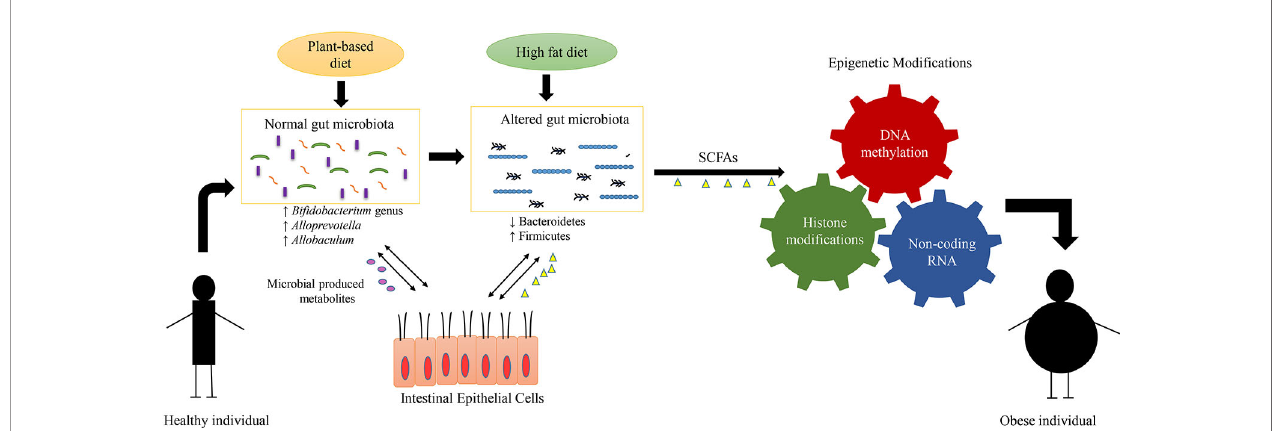
FIGURE 2 | Interplay between diet, gut microbiome, epigenetic mechanisms, and obesity. The alterations in composition of microbial communities mainly arise due to difference in dietary patterns. The plant-based diets have been known to be associated with diverse and particular gut fl ora such as Bi fi dobacterium genus, Alloprevotella, and Allobaculum . The diverse composition of gut microbiota results in production of various metabolites such as short-chain fatty acids (SCFA). These gut microbial-produced metabolites interact with the epithelial cells of the host and help to maintain the host metabolism. On the other hand, the diets enriched in fat and carbohydrate, result in lowered gut diversity and alterations in the composition of gut microbiota such as decrease in levels of Bacteroidetes and increase in levels of Firmicutes. This gut dysbiosis (alterations in composition and function of gut bacteria) produce metabolites that induce speci fi c epigenetic alterations such as DNA methylation, histone modi fi cation and noncoding RNA, which in-turn regulate the development of